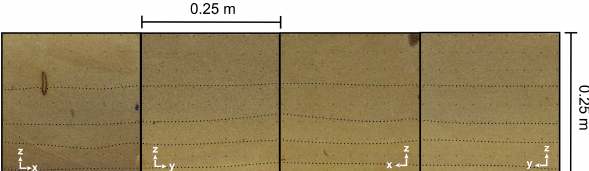
Figure 2. Lateral faces of OSB1_c displayed in the form of an open cube (from left to right: XZ front, YZ front, XZ back and YZ back). The internal bounding surfaces are indicated by the dotted